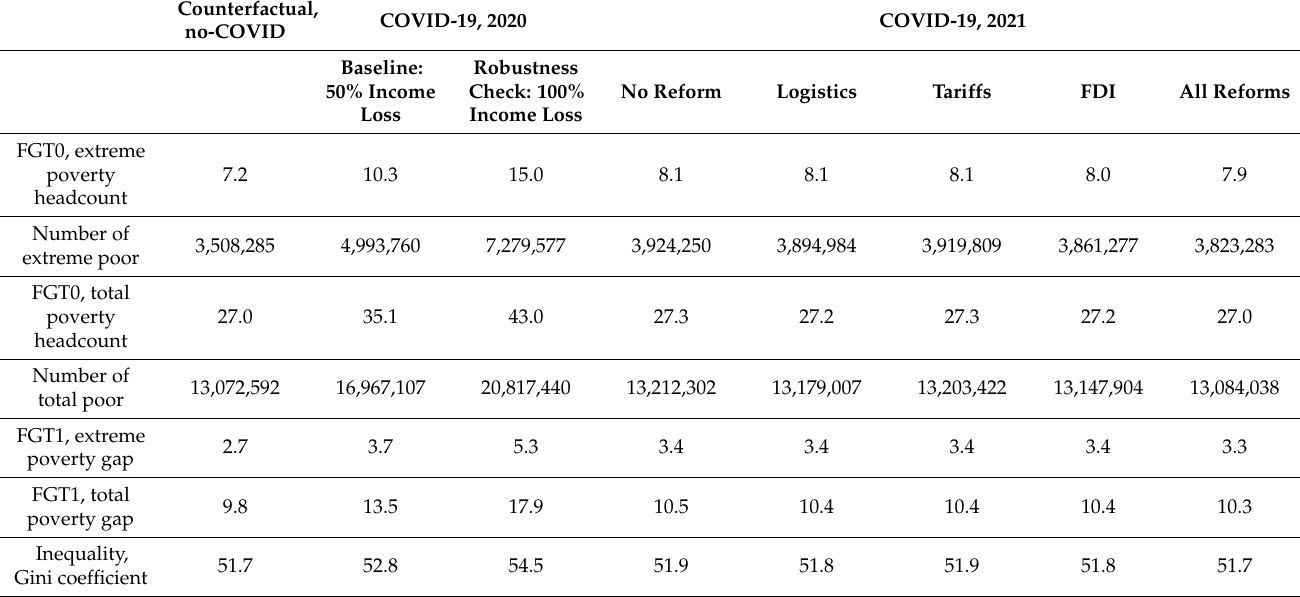
Table 5. Simulated effects of COVID-19, recovery, and reforms on poverty and